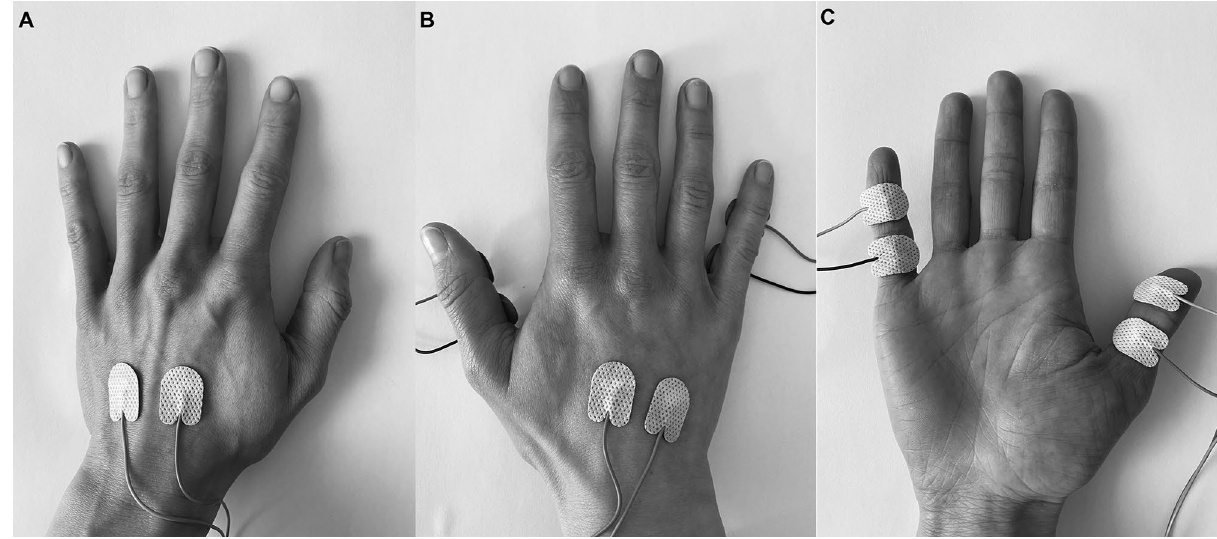
Figure 2. Illustration of the experimental setup (electrode placement). Stimulation was applied via adhesive surface electrodes attached to ( A ) the back of the left hand, ( B ) the back of the right hand and ( C ) the palmar side of the thumb and little finger of the right hand. Responses were given by pressing the left or right control key with the respective index finger.